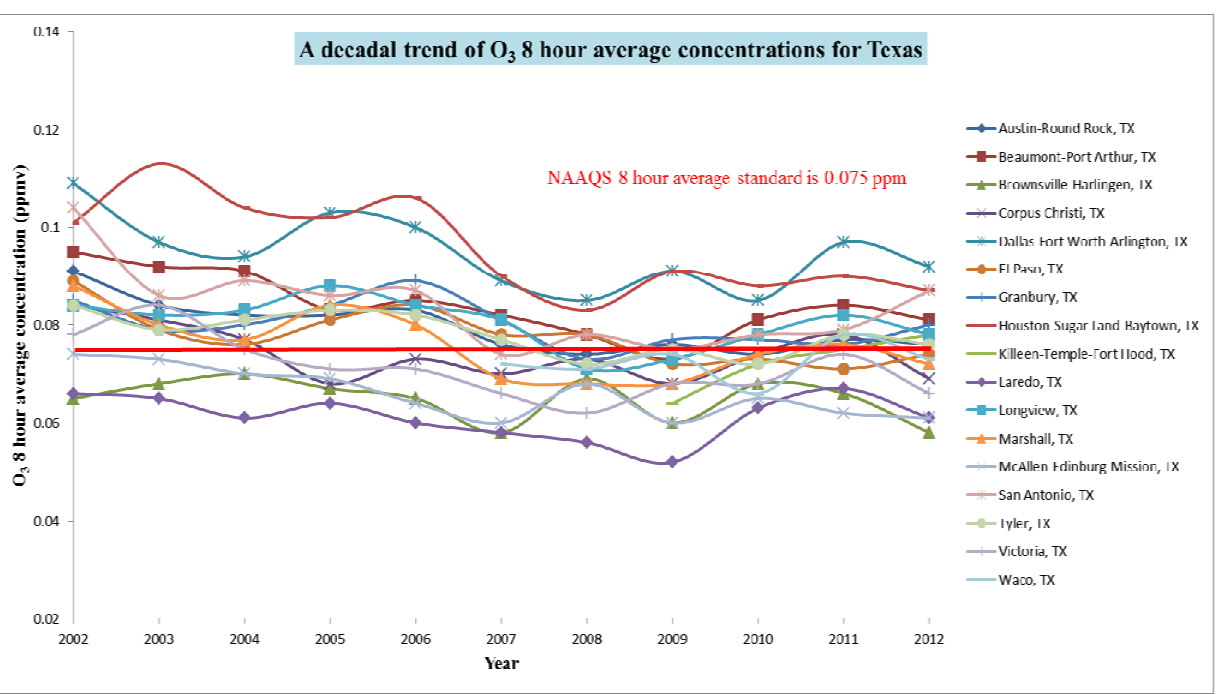
Figure 8. Air quality statistics- Maximum 8 hour average trend of Ozone in Texas for the last decade (data were obtained from US EPA